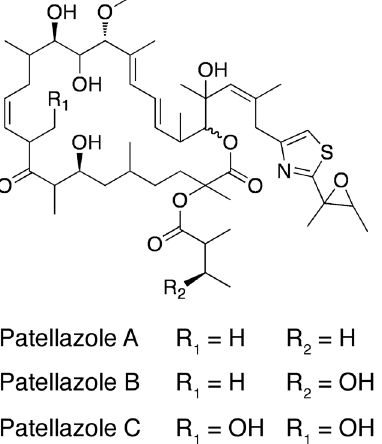
Figure 1. Structures of patellazoles A–C [ 11,12 ] , picomolar cytotoxins isolated from the tunicate Lissoclinumpatella that likely act as chemical defenses.